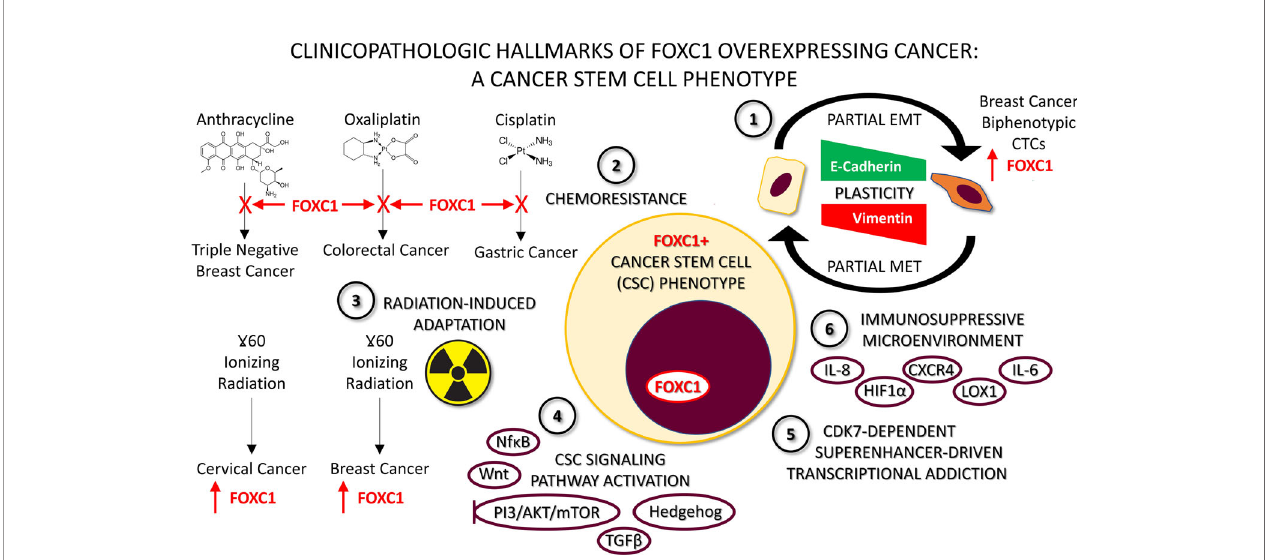
FIGURE 2 | Characteristics of FOXC1-overexpressing pro-metastatic cancers. 1. Plasticity whereby FOXC1+ cells undergo partial Epithelial-to-Mesenchymal Transition (EMT), and can revert back by undergoing a partial Mesenchymal-to-Epithelial Transition (MET). Detection of FOXC1+ E/M hybrid biphenotypic Circulating Tumor Cells (CTCs) in the peripheral blood of breast cancer patients provides clinical evidence supporting the occurrence of this phenomenon in vivo . 2. Chemoresistance to a variety of chemotherapeutic agents driven by FOXC1 has been described in multiple cancer types with varied mechanisms. 3. Radiation- induced adaptation and subsequent resistance has been described in two different types of cancer cell line models to be characterized by FOXC1 overexpression. 4. Stem cell pathway activation, particularly of the non-canonical variety has been described for NF ĸ B, Wnt, Hedgehog, PI3K/AKT/mTOR and TGF b signaling pathways in cancer. Moreover, they all converge on FOXC1. This has led to the suggestion that combination therapy with two or more pathway inhibitor drugs may be necessary to block FOXC1-driven cancer metastasis. 5. Superenhancer-driven transcriptional addiction to FOXC1 mediated by CDK7 has been described in breast cancer and was shown to be effectively thwarted using a CDK7 inhibitor drug. 6. FOXC1 contributes to an immunosuppressive microenvironment by upregulating multiple immunosuppressive factors including HIF1 a , CXCR4, CXCR1 and LOX1. This helps explain how the cancer stem cell phenotype helps evade immune detection, and how FOXC1+ cancers are a valid target for immunotherapy approaches like immune checkpoint